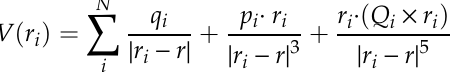
Figure S1. ORTEP view of 1 . Thermal ellipsoids are drawn at 30% probability; Figure S2. ORTEP view of 2 . Thermal ellipsoids are drawn at 30% probability; Figure S3. Molecular Electrostatic potential centered on the lanthanide ion for 1 (left) and 2 (right). The orientation of the ground state anisotropy axis is represented as a dark line. Figure S4. Frequency dependence of in-phase ( χ M ’) and out-of-phase components ( χ M ”) at 5 K for 1 in a zero applied magnetic field. Red lines are the best fitted curves; Figure S5. Frequency dependence of χ M ’ in the temperature range ( a ) 2–14 K for 1 and ( b ) 2–20 K for 2 in a zero applied magnetic field; Figure S6. Normalized Argand plot between 2 and 14 K for 1 in a zero applied magnetic field; Figure S7. Normalized Argand plot between 2 and 14 K for 2 in a zero applied magnetic field; Figure S8. Frequency dependence of χ M ’ at 2 K at various external fields for ( a ) 1 and ( b ) 2 ; Figure S9. Frequency dependence of χ M ’ in the temperature range 2–14 K for ( a ) 1 and for ( b ) 2 in a 1200 and 1000 Oe applied magnetic field, respectively; Figure S10. Normalized Argand plot between 2 and 14 K for 1 in a 1200 Oe applied magnetic field; Figure S11. Normalized Argand plot between 2 and 14 K for 2 in a 1000 Oe applied magnetic field; Table S1: X-ray crystallographic data for 1 and 2 ; Table S2: Computed energies, g -tensor and wavefunction composition of the ground state doublet in the e ff ective spin 1 / 2 model for 1 ; Table S3: Computed energies, g -tensor and wavefunction composition of the ground state doublet in the e ff ective spin 1 / 2 model for 2 ; Table S4: Best fitted parameters ( χ T , χ S , τ and α ) with the extended Debye model 1 at 0 Oe in the temperature range 2–13 K; Table S5: Best fitted parameters ( χ T , χ S , τ and α ) with the extended Debye model 2 at 0 Oe in the temperature range 2–13 K; Table S6: Best fitted parameters ( χ T , χ S , τ and α ) with